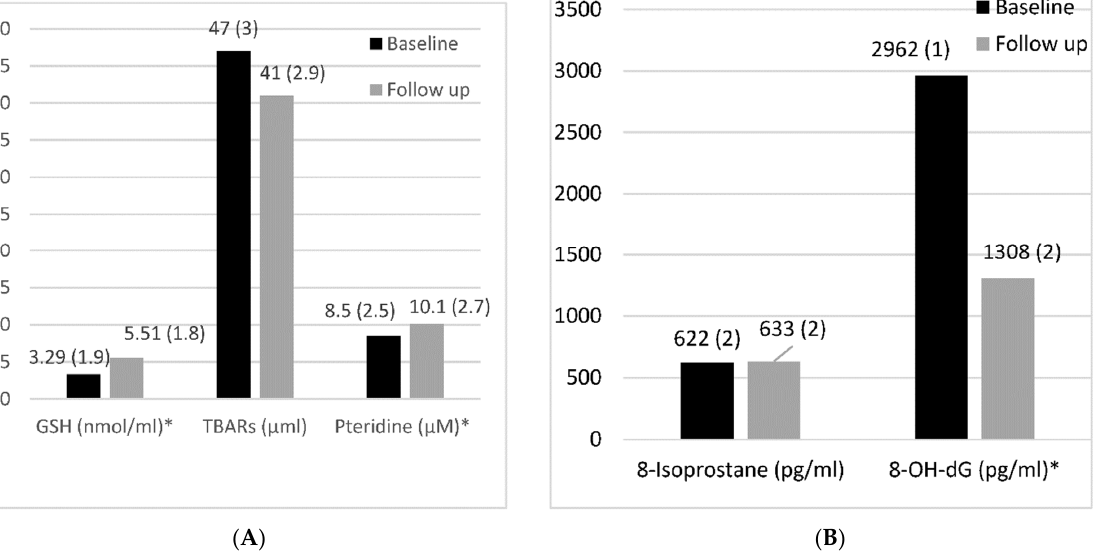
Figure 1. Baseline and follow-up of ( A ) urinary GSH, TBARS, and pteridine, and ( B ) 8-isoprostane and 8-OH-dG. Values represent geometric mean ± SD; * p < 0.05 for difference between baseline and follow-up.